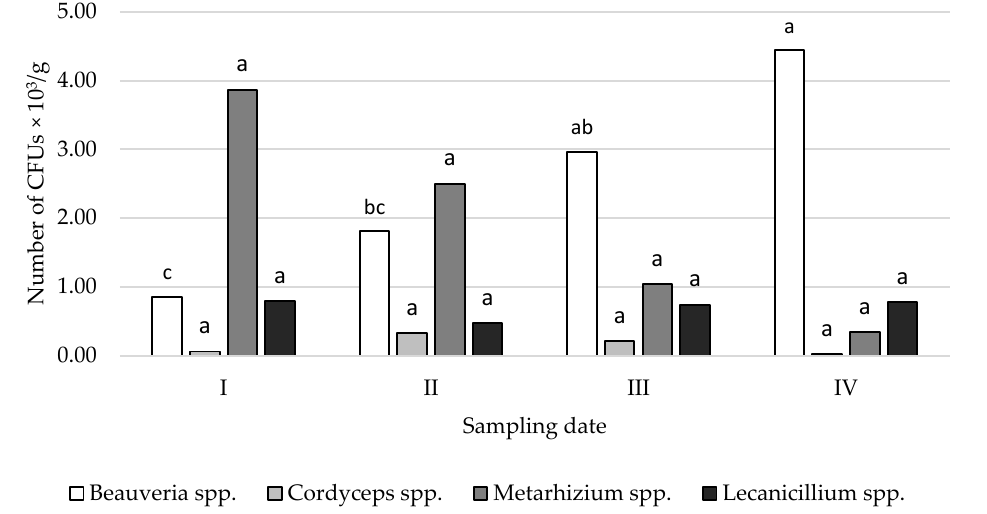
Figure 3. Average density of CFUs of entomopathogenic fungi in forest soils collected in Golice depending on the date of sampling for research. abc Statistically significant differences between the concentration of CFUs of entomopathogenic fungi in the studied soils and the time of the study.